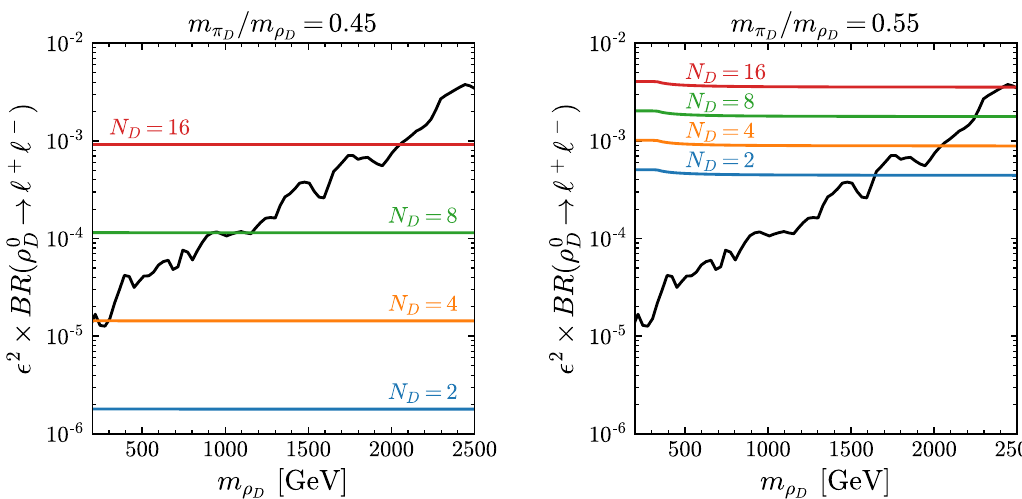
Figure 4 . Constraints on the kinetic mixing between the the SM and ρ 0 branching fraction of ρ 0 line is the model-independent limit. To illustrate the impact of this bound on the model space, we have superimposed the predicted (cid:29) 2 of colors between 2 to 16. On the right, the 2-body decay ρ 0 leading to strong constraints: m open, and we see that when N to